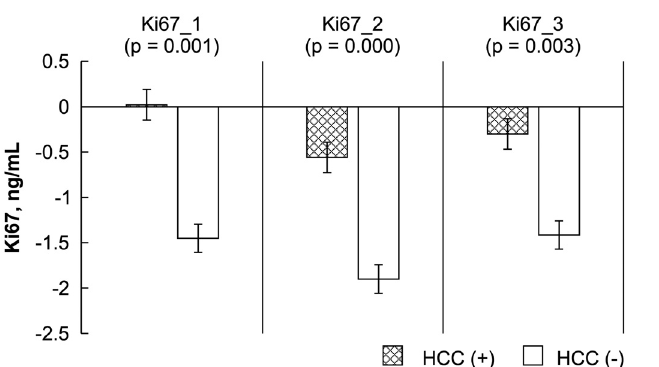
Fig 2. Statistical analysis of FGF-2, survivin, Ki67, endostatin, and VEGF levels, as measured by ELISA before (_1), early after (_2), and late after (_3) after living donor liver transplantation (LDLT). The Mann-Whitney U test was used to compare the differences in the biomarkers at the various time points between the recipients with and those without HCC recurrence.